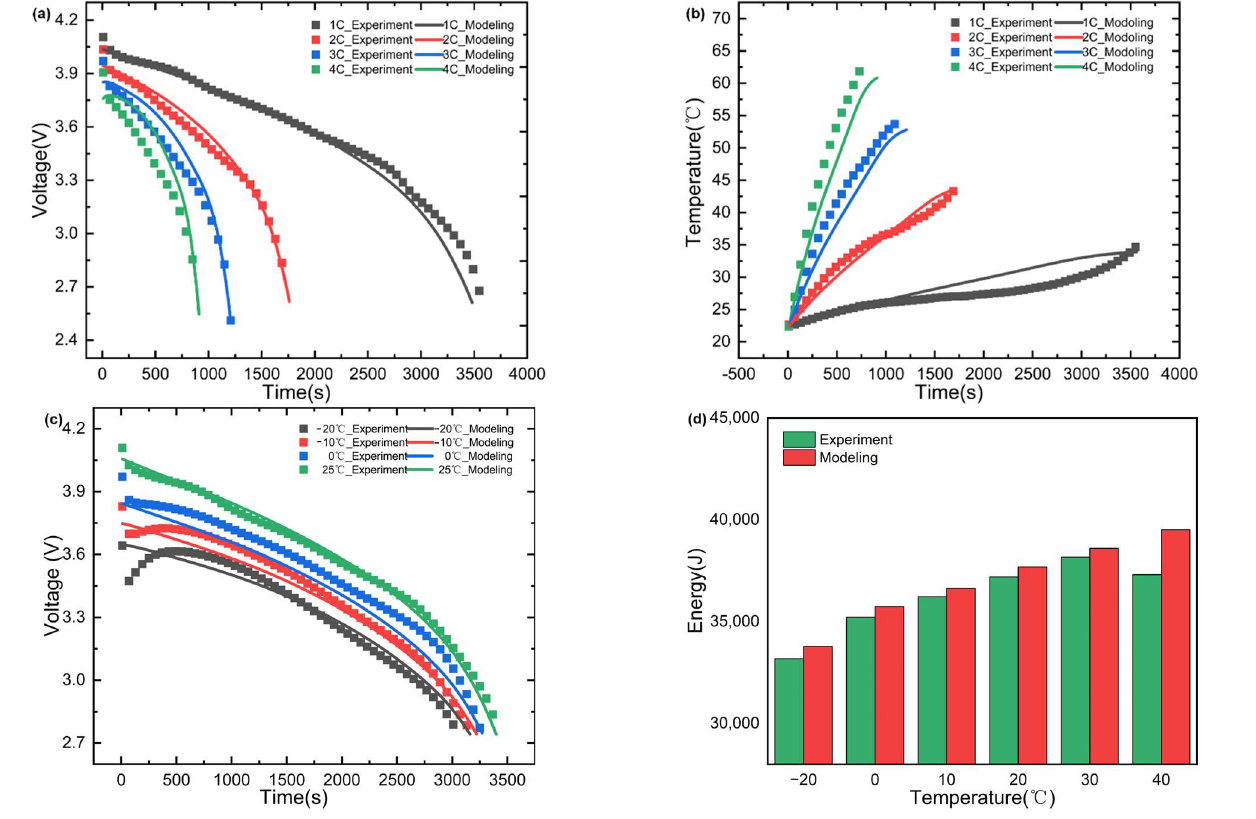
Figure 2. Comparison of NTGK model simulation results with experimental data. ( a ) Voltage curves; ( b ) Temperature curves at 22.4 °C; ( c ) voltage curves; ( d ) histograms of energy for 1C discharge of lithium-ion battery.